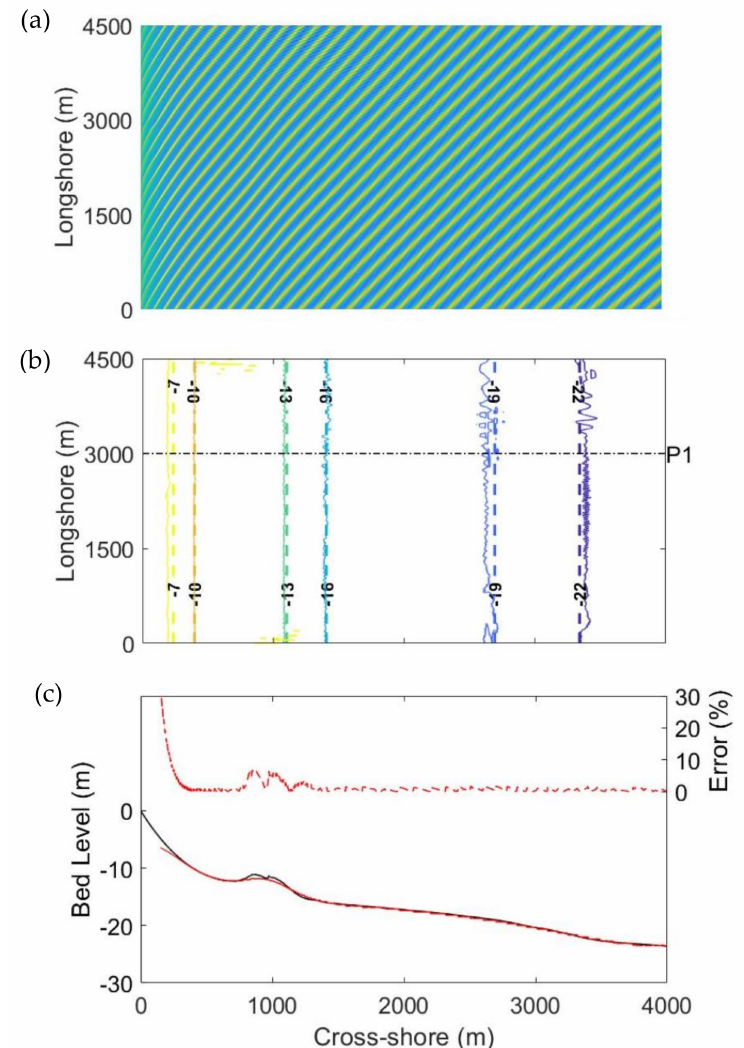
Figure 5. Regular waves propagating over a sandbar at oblique incidence: ( a ) generated image representing the two-dimensional wave propagation at the surface; ( b ) isobaths of the calculated bathymetry (continuous lines) over the FUNWAVE bathymetry (dashed lines); ( c ) cross-shore profile P1 (real—black line; estimation using wavelets—red line) and respective relative errors. FUNWAVE numerical simulations performed with H = 2 m, T = 10 s, θ = 30 ◦ , and dx = 1 m. Total simulation time was 2500